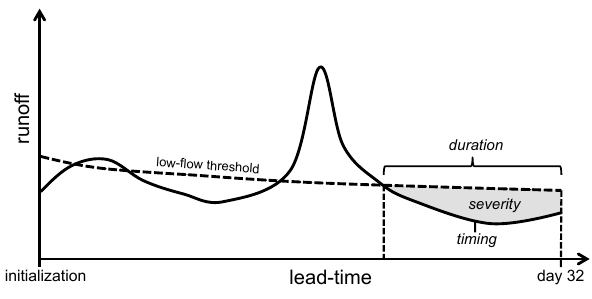
Fig. 3. Illustration of the streamflow drought indices considered in this study. The solid line is the observed or forecast runoff, i.e., in certain periods, above or below the streamflow drought detection threshold (dashed line). For each forecast member of each 32-day forecast and the corresponding observation, the longest consecutive period below the threshold (streamflow drought duration) is eval- uated. The water deficit during this period (severity, shaded area) is the cumulative difference between the threshold and runoff. The quotient of severity and duration, called magnitude, is evaluated as well. Timing is defined as the moment when half of the event has